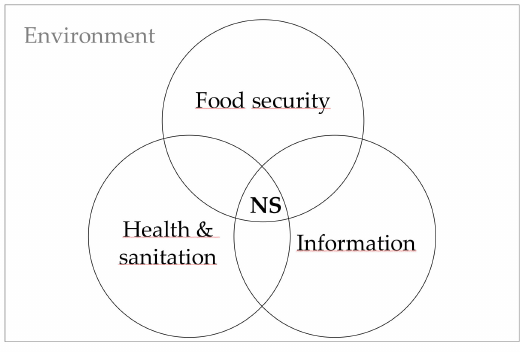
Figure 1. Conceptual framework of nutrition security (NS) adapted from Sanchez-Griñan